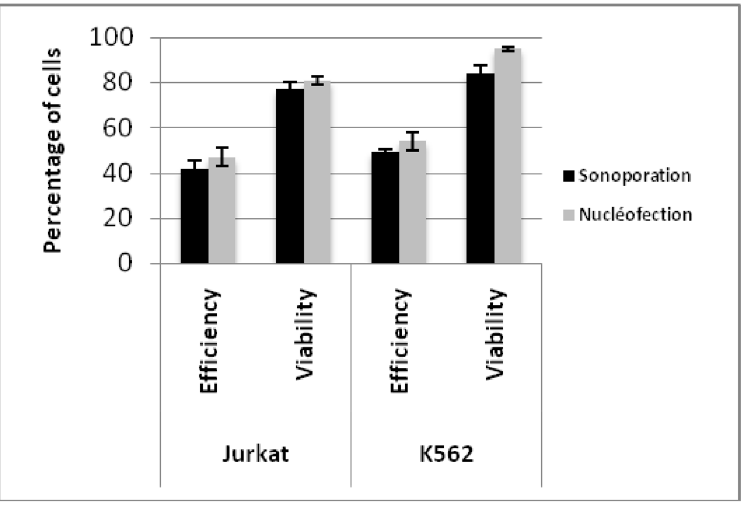
Fig 6. Comparison of the transfection efficacy of pEGFP-C1 with sonoporation and nucleofection. Transfection efficiency (black bar) and cell viability (grey bar) were determined by flow cytometry analysis 24 hours post-sonoporation and nucleofection of non-adherent JURKAT and K562 cell lines. The error bars represent the mean ( ± standard deviation, SD) of triplicate